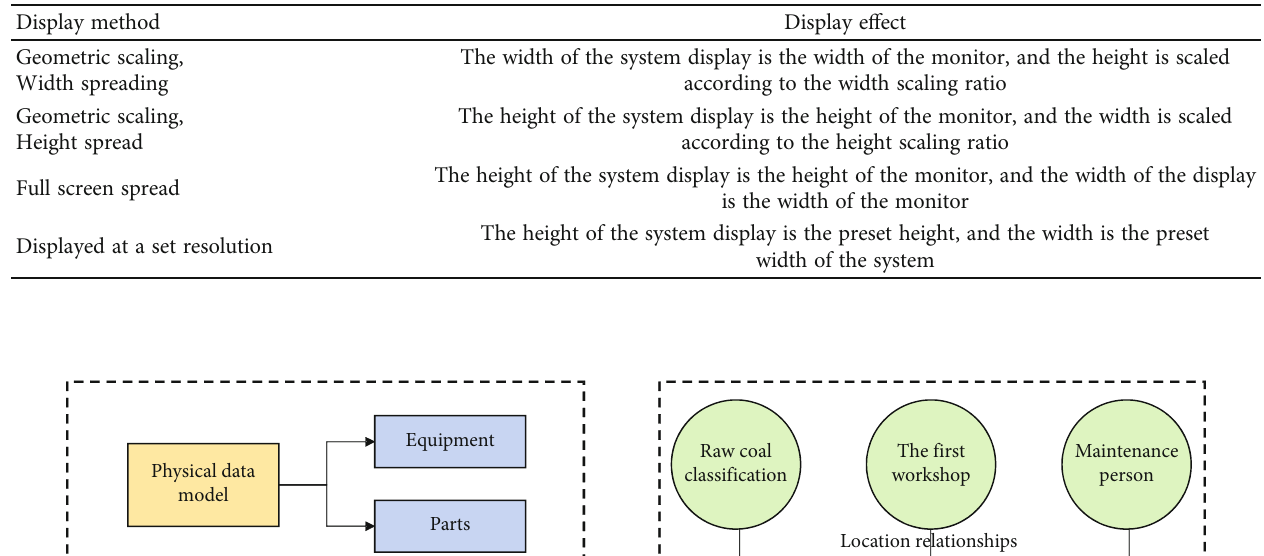
Table 2: Visualization display standards.